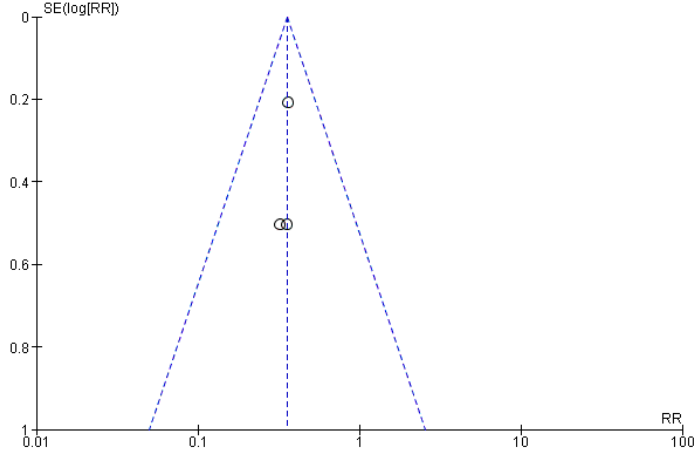
Figure 3. Meta-analysis funnel plot. The presence of symmetry demonstrates the potential possibility of not presenting the bias of publication.